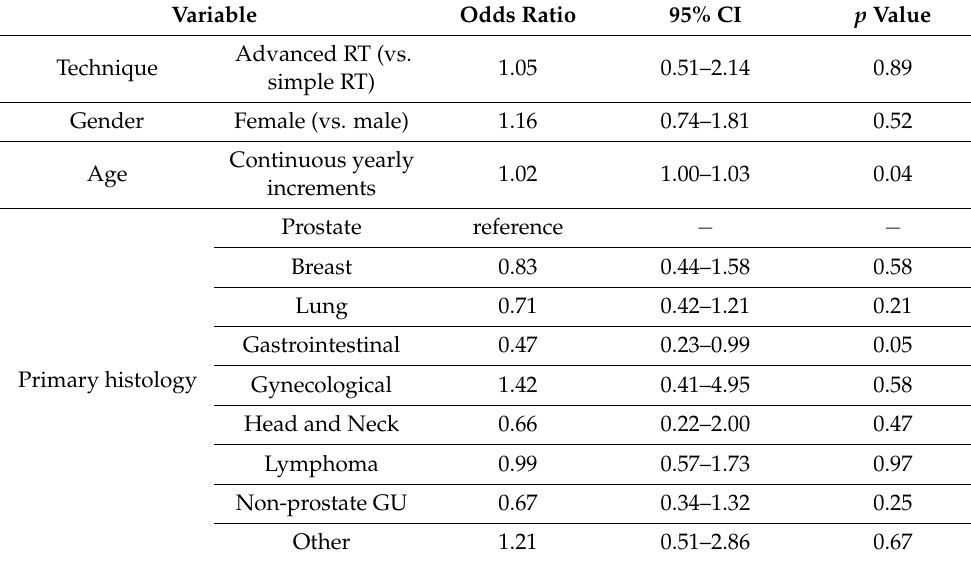
Table 4. Multivariable analysis of complete pain